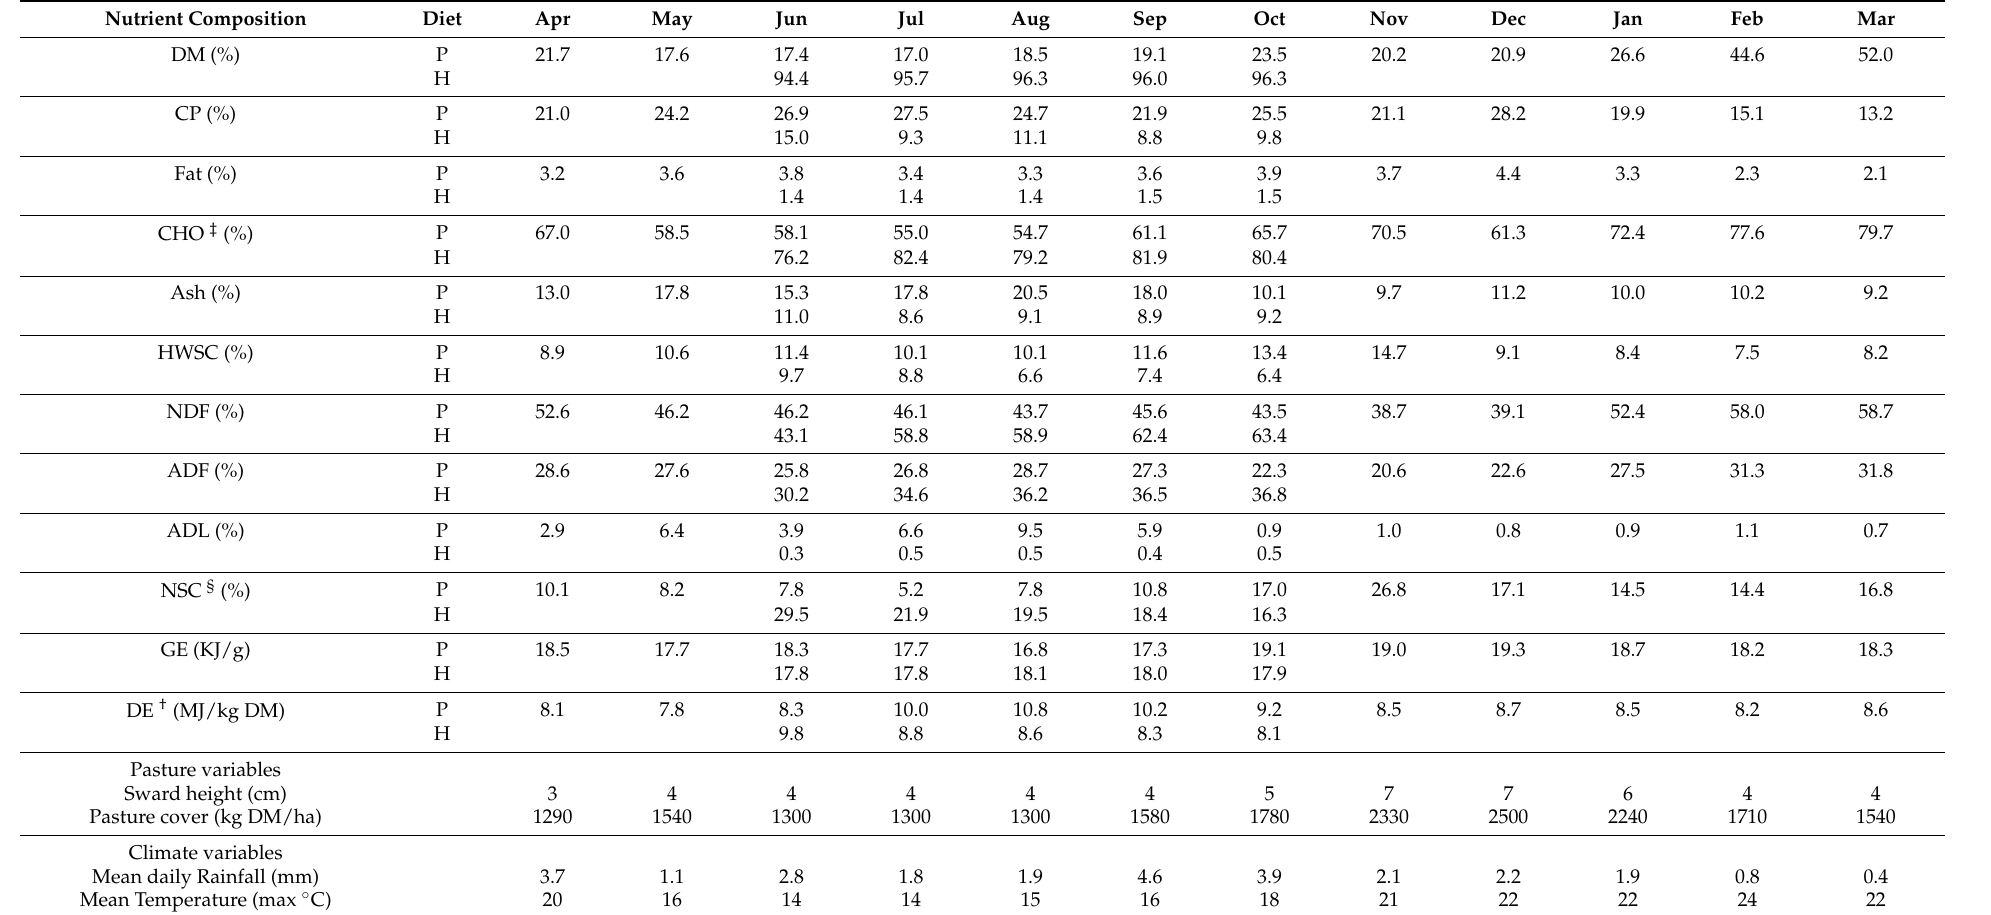
Table 1. Nutrient composition of pasture and hay and climate variables measured over a period of 12